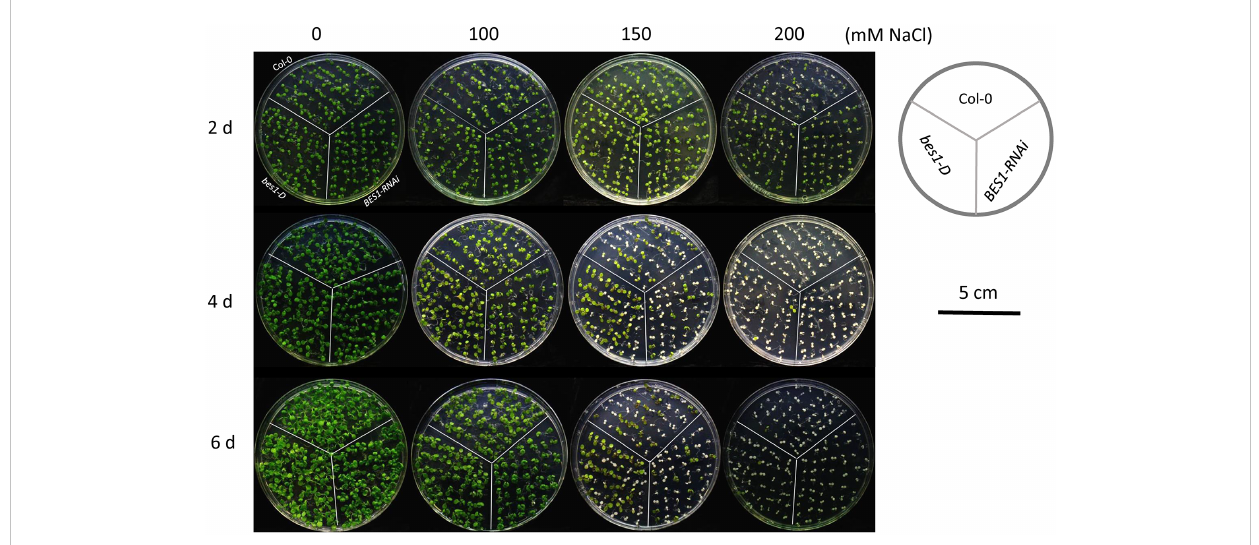
FIGURE 1 Phenotypic analysis of bes1-D and BES1-RNAi under salt stress. Col-0, a wild type; bes1-D , a gain-of-function mutant for BES1; BES1-RNAi , a loss- of-function mutant for BES1. Growth media with different concentrations of NaCl (0, 100, 150 and 200 mM) were used for the treatment. Photos were taken at the 2nd, 4th, and 6th day of the